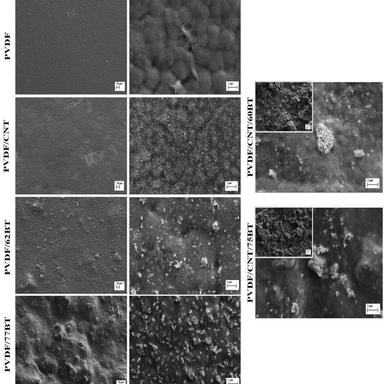
SEM micrographs of PVDF, binary PVDF/CNT and PVDF/xBT and ternary PVDF/CNT/xBT films at different compositions.